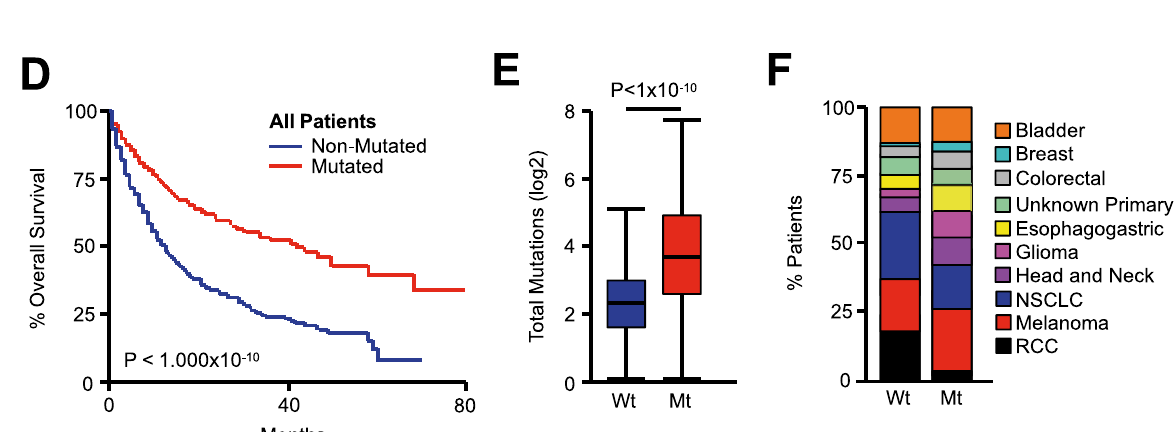
Figure 2. Mutations to genes associated with improved overall survival in the pan-cancer cohort. ( A , B ) Patients from the MSKCC pan-cancer cohort (N = 1661) were arranged by final vital status, and differentially mutated genes were arranged by volcano and scatter plot with those significantly different between the two groups shown in blue. ( C ) The 13 most differentially mutated genes are presented by percent mutated in each group, and shown with the corresponding false discovery rate (FDR)-adjusted P value. ( D ) Kaplan Meier plot showing overall survival for patients with or without a mutation in one or more of these 13 genes. (N = 1661 consisting of 610 patients with one or more mutation and 1051 non-mutated patients). ( E , F ) The total number of mutations and tumor types represented in patients with or without a mutation in one or more of these